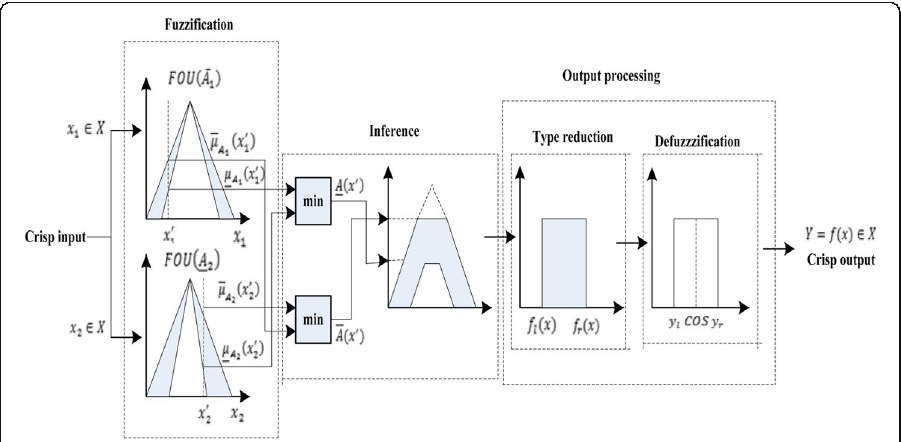
Fig. 8 An example of a type-2 fuzzy inference